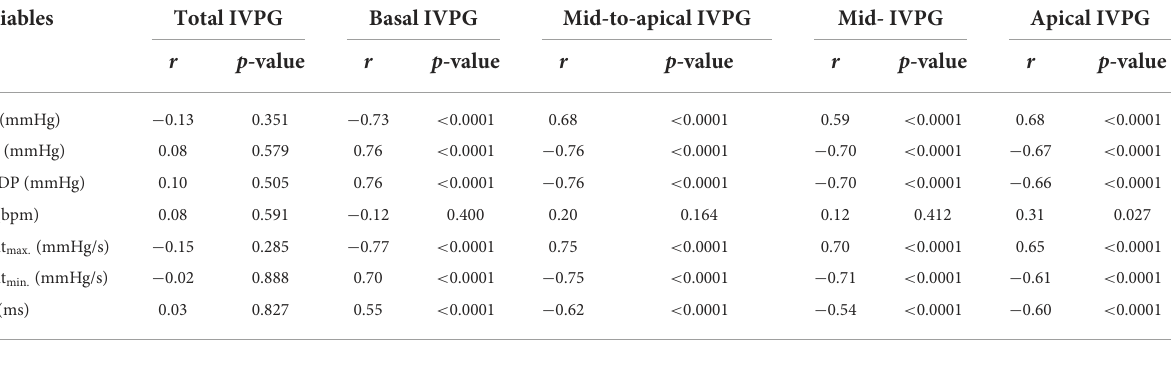
TABLE 5 Correlation between IVPG, anatomic parameters, and infarct size. Variables Total IVPG Basal